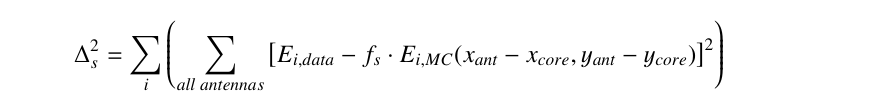
di ff erent values of ∆ 2 ( f s ,(cid:30) r core ) for each simulation. But only the minimum value (denoted simply s